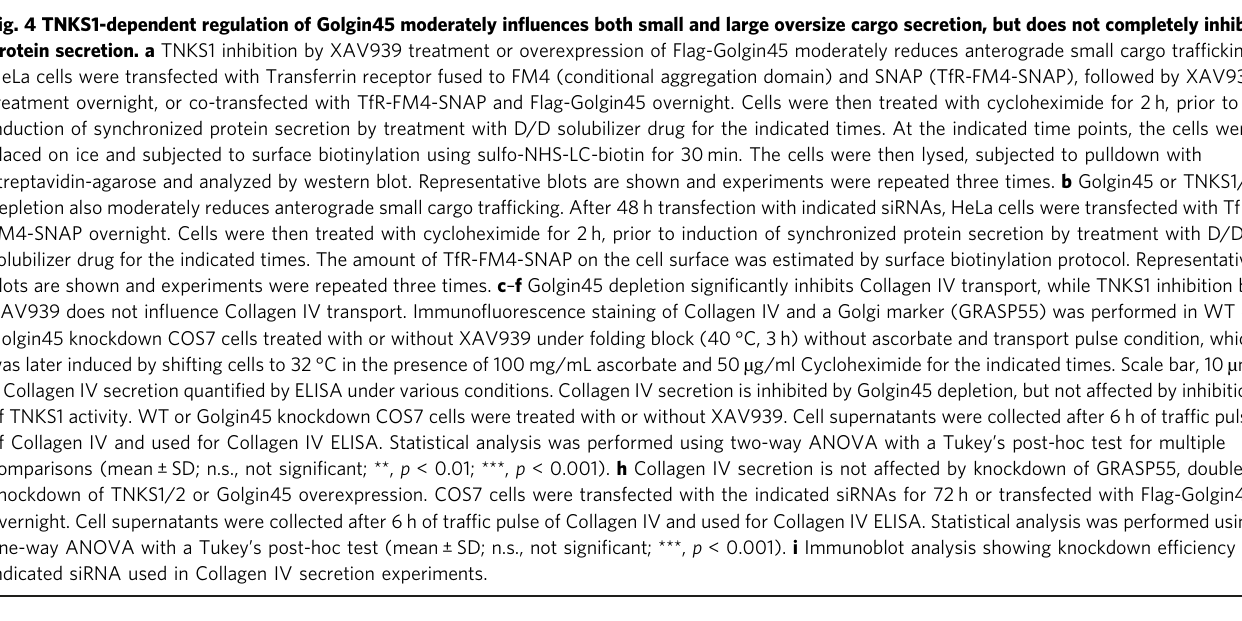
Fig. 4 TNKS1-dependent regulation of Golgin45 moderately in fl uences both small and large oversize cargo secretion, but does not completely inhibit protein secretion. a TNKS1 inhibition by XAV939 treatment or overexpression of Flag-Golgin45 moderately reduces anterograde small cargo traf fi cking. HeLa cells were transfected with Transferrin receptor fused to FM4 (conditional aggregation domain) and SNAP (TfR-FM4-SNAP), followed by XAV939 treatment overnight, or co-transfected with TfR-FM4-SNAP and Flag-Golgin45 overnight. Cells were then treated with cycloheximide for 2 h, prior